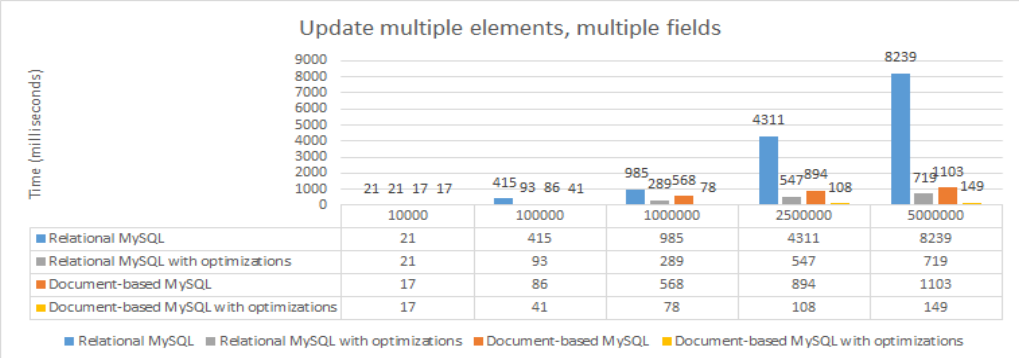
Figure 6. Performance time (ms) for the update multiple elements and one field operation.